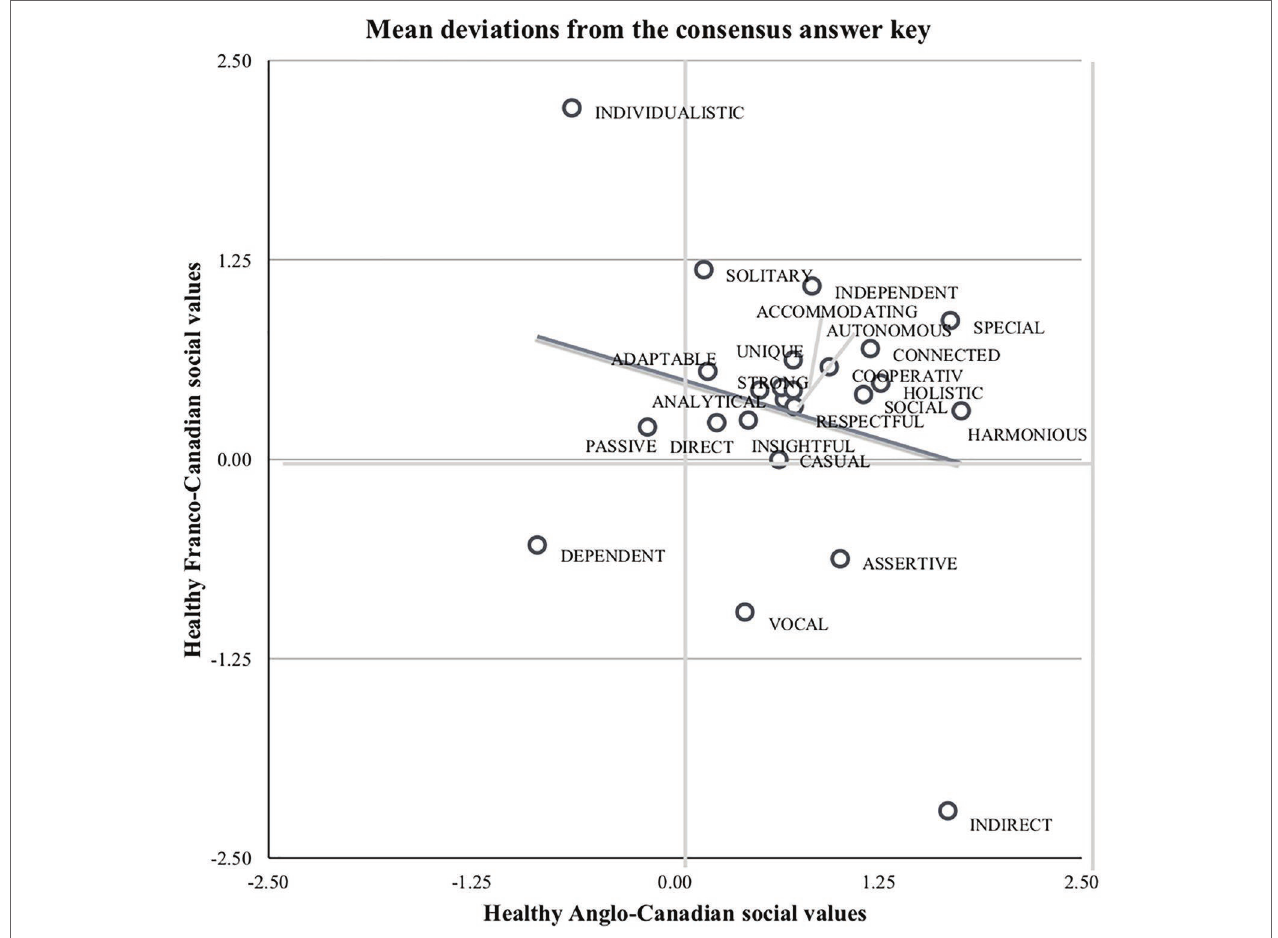
FIGURE 1 | Adjusted ratings depict patterns of social values across Canadian cultural groups. When considering culture, the varying degrees to which social values are held characterize the priorities of group members and degrees of differences between groups. The constellations of social values across Canadian cultures according to the CCA factor dimension illustrate distinct patterns between Franco- and